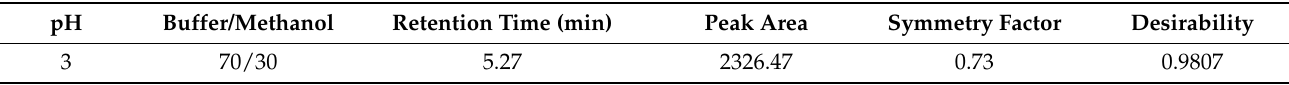
Table 4. Obtained solution for optimized formulation.